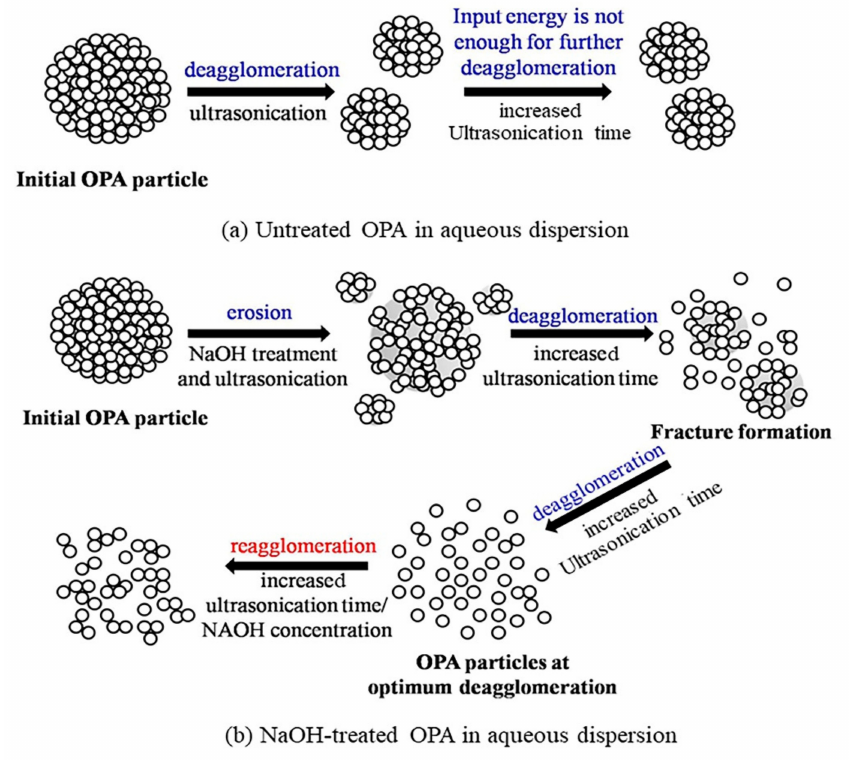
Figure 6. Schematic diagram showing the changes in particle size and morphology of ( a ) untreated OPA under ultrasonication and ( b ) NaOH-treated OPA, as a function of ultrasonication